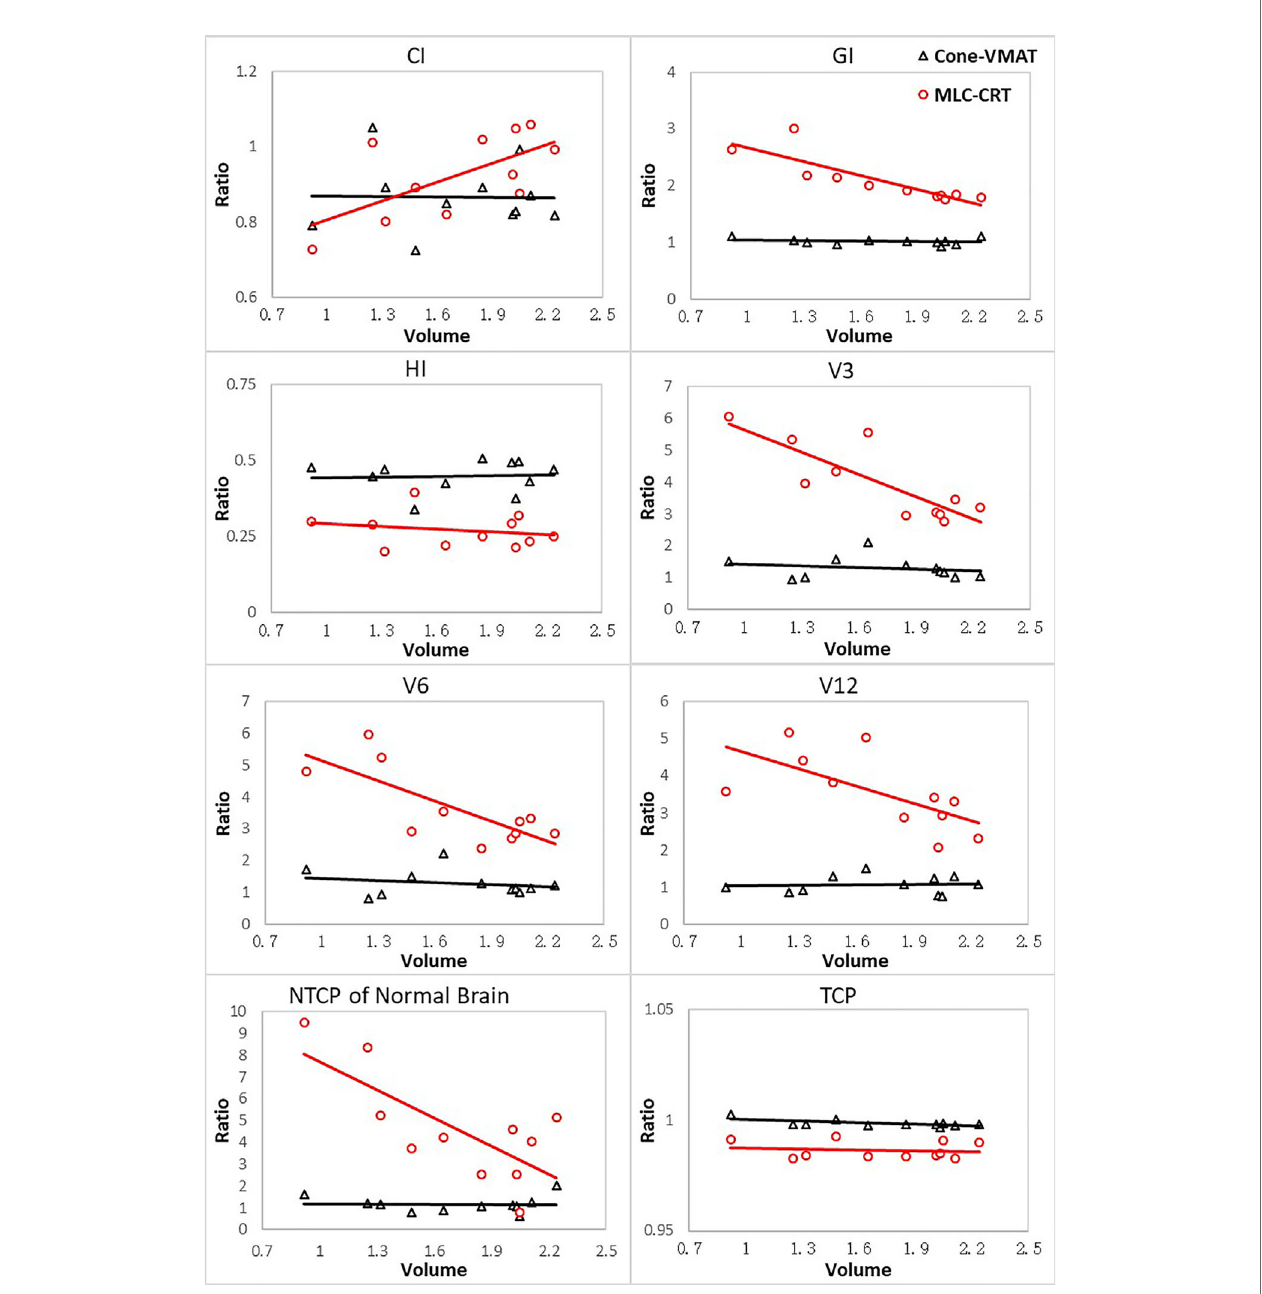
FIGURE 2 | The ratios of parameters for other two techniques relative to GK with respect to different PTV volumes. Volumes are in cm 3